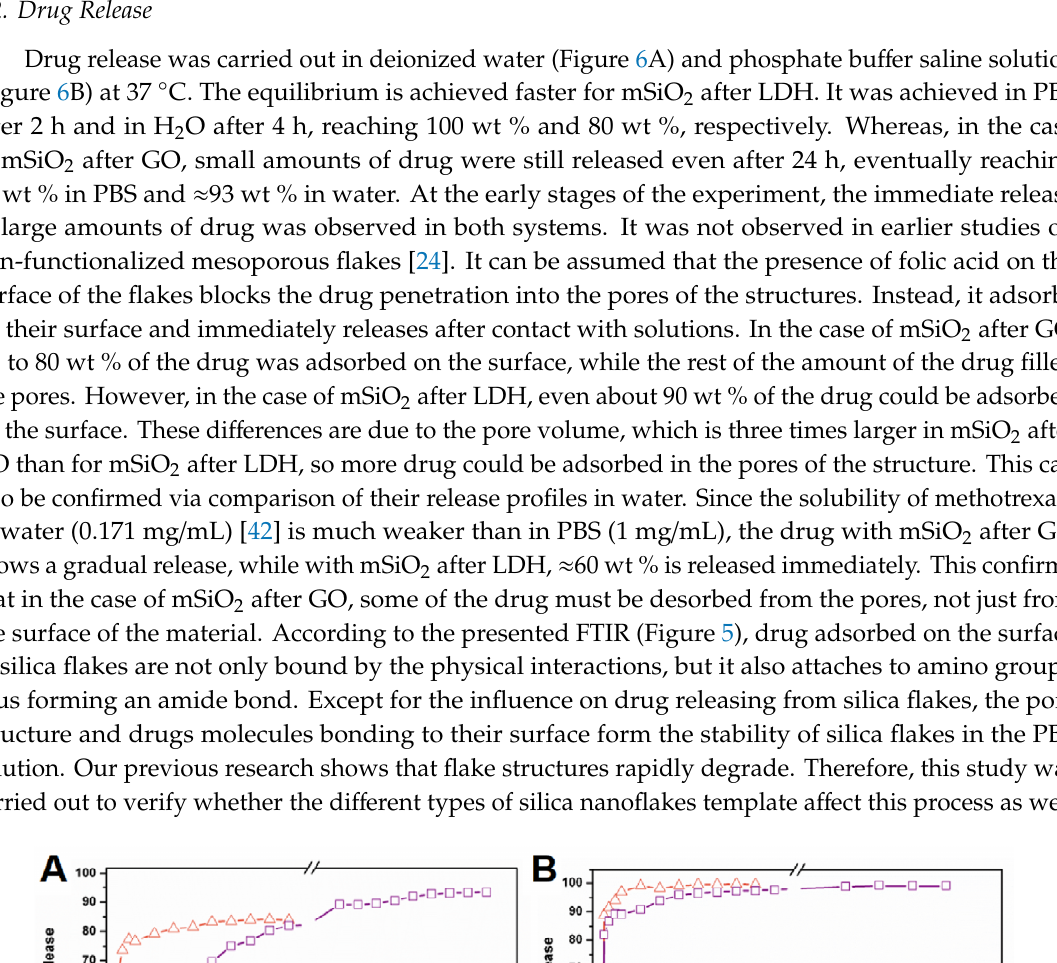
Figure 5. FTIR spectra of silica flakes functionalized with folic acid loaded with methotrexate (MTX):